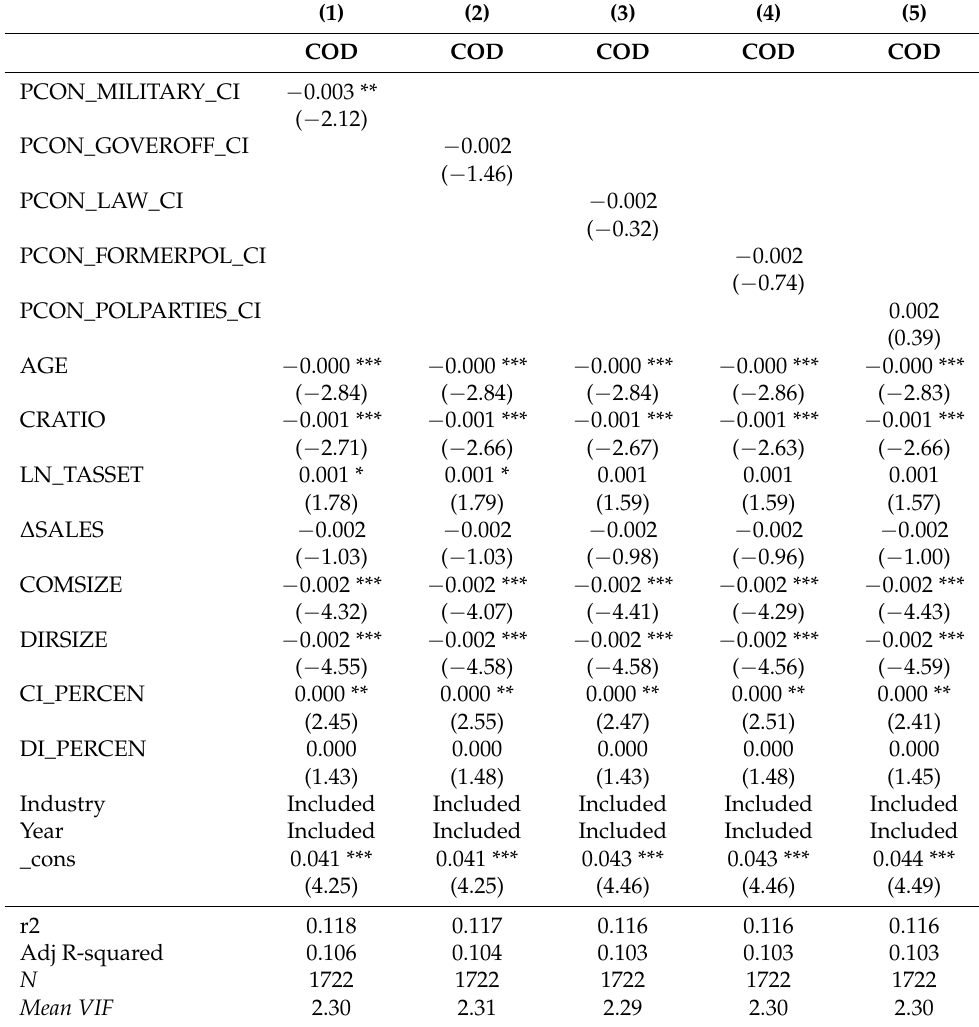
Table 12. Regression of 5 categories of political connections independent commissioners to the cost of